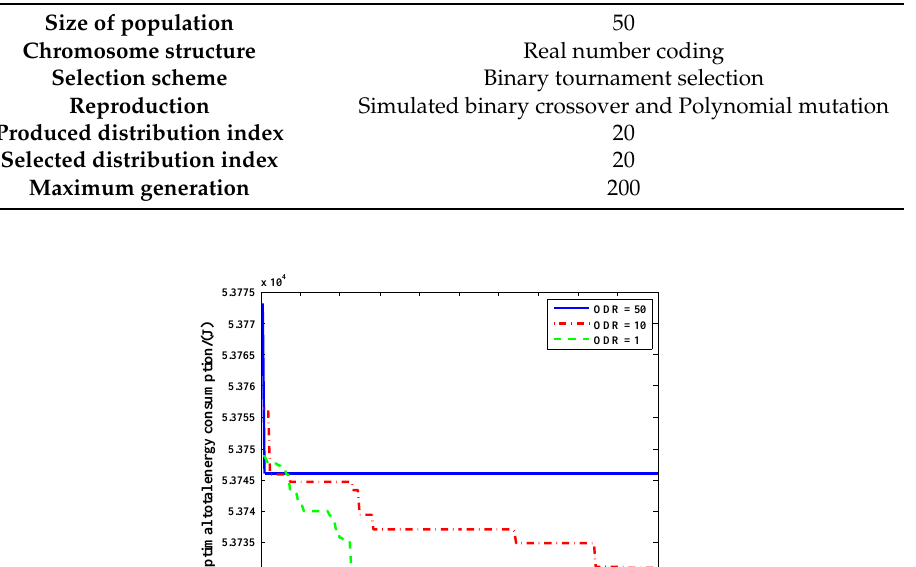
Table 9. Parameters of proposed non-dominated sorted genetic algorithm-II (NSGA-II) method.